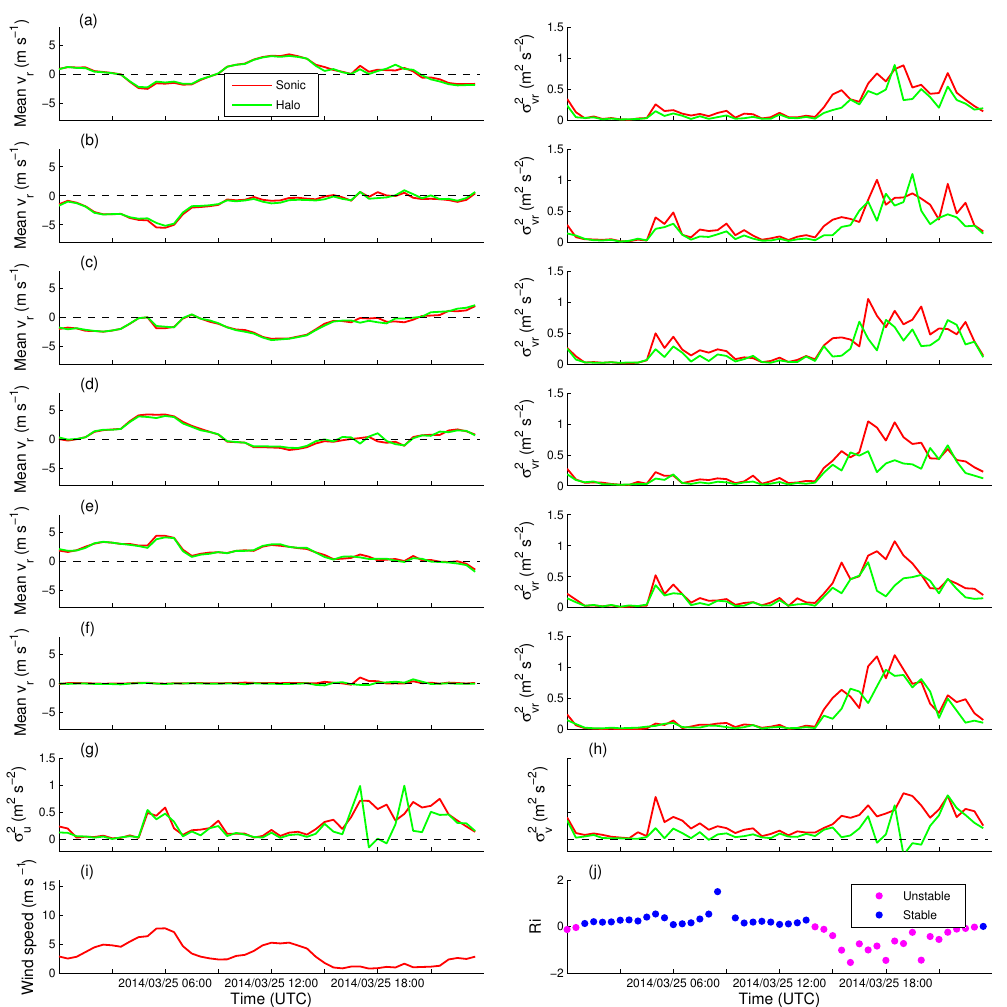
Figure 7. 30min mean velocity values (left panels) and variance values (right panels) for (a) v r1 , (b) v r2 , (c) v r3 , (d) v r4 , (e) v r5 , and (f) v r6 measured by Halo lidar and calculated from projected sonic data. Values of (g) u variance and (h) v variance are also shown for reference, where sonic values are from standard variance calculation and Halo values are from six-beam calculation. Mean wind speed from sonic is shown in (i) and Richardson number from tower is shown in (j) . Data are shown from 25 March 2014 at 200ma . g . l . at the BAO